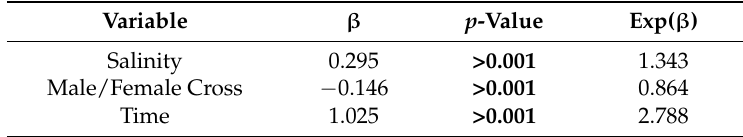
Table 2. Binomial logistic regression of hatching probability in A. cf. solaris. A full model found that all possible interactions yielded p > 0.250, and so the results of a reduced model using only main effects are presented. Significant effects are in bold.